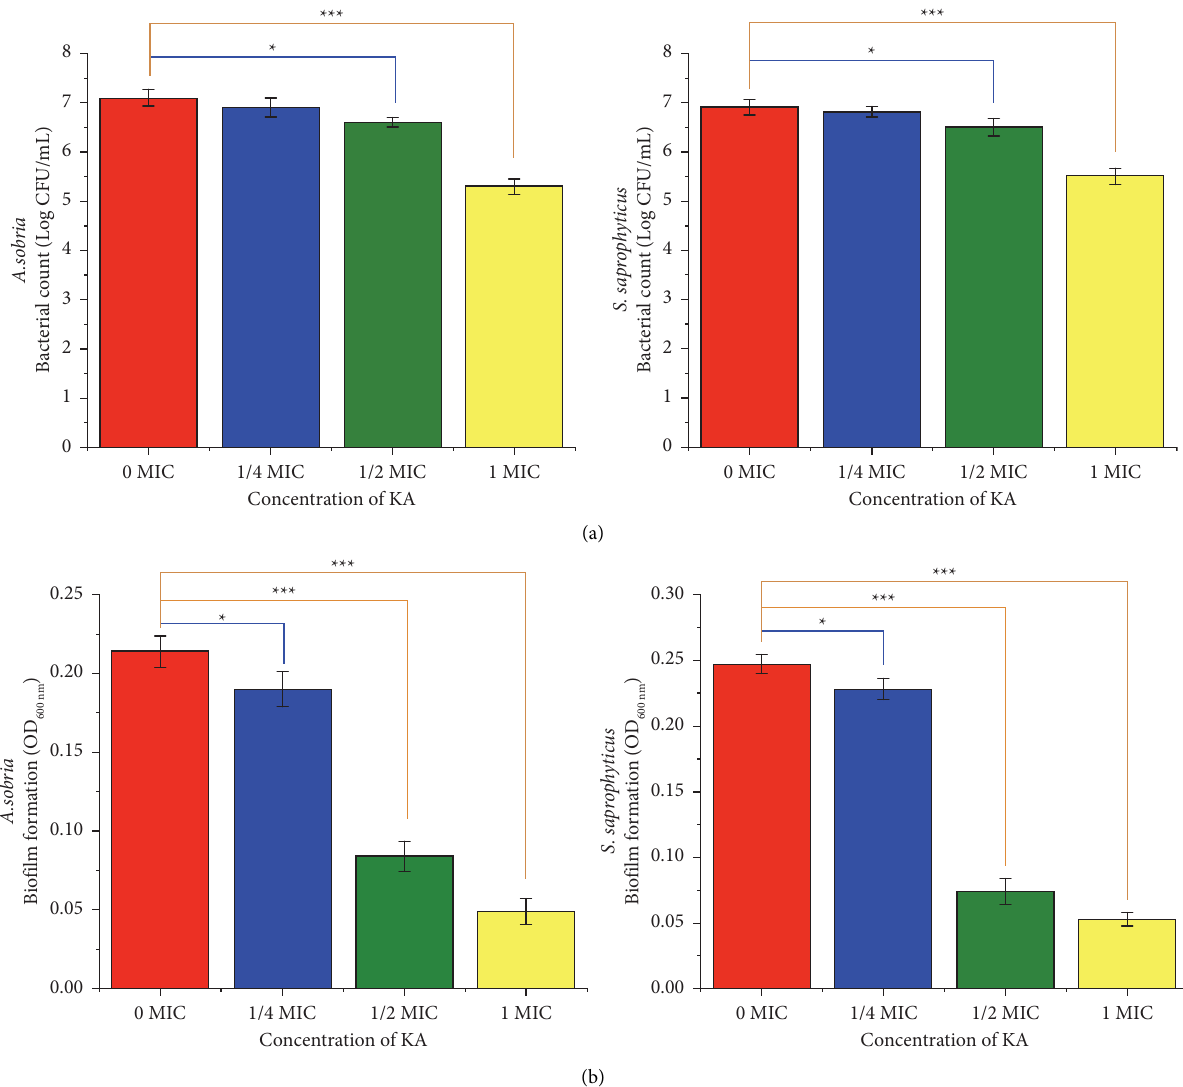
Figure 3: Efect on bioflm formation of A. sobria and S. saprophyticus after KA treatment at diferent densities at 30 ° C for 24h. (a) Surviving planktonic cells in the culture supernatant treated with KA. (b) Bioflm formation. ∗ P < 0.05; ∗∗ P < 0.01; ∗∗∗ P <